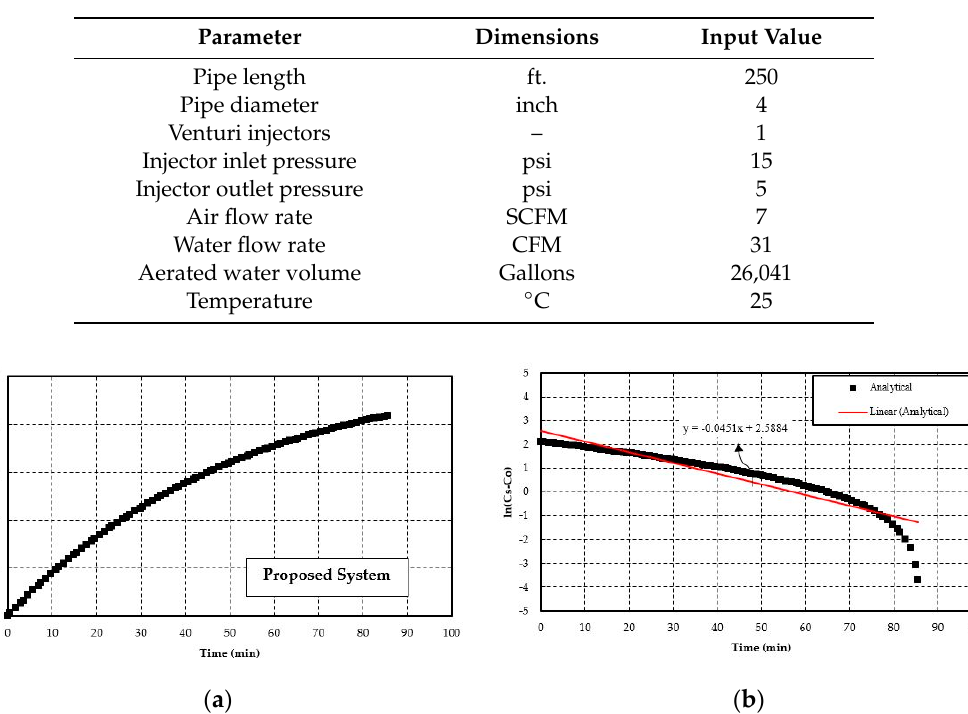
Table 5. Di ff erent physical parameters for the proposed system.